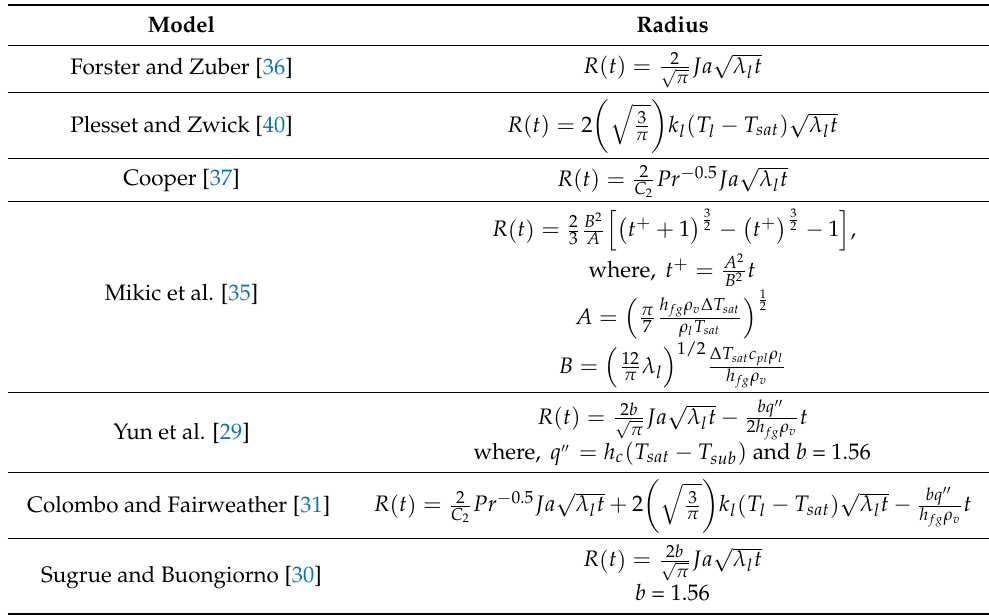
Table 2. Summary of popular models used for bubble